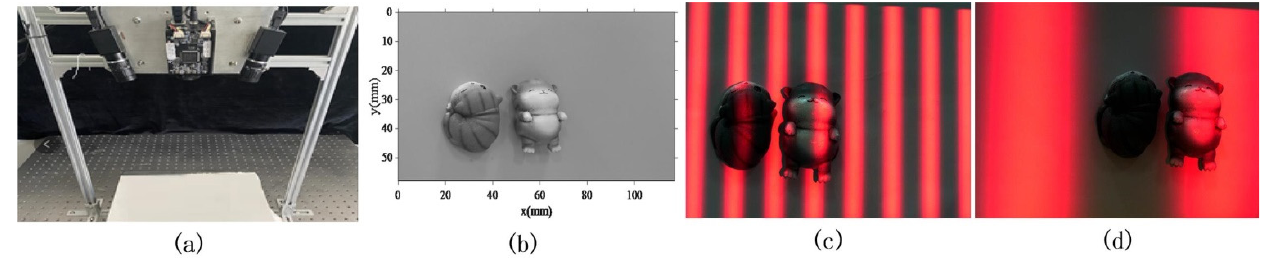
Figure 1. The isolated objects and fringe pattern. ( a ) The structure of the reconstruction system; ( b ) the image of the isolated objects; ( c ) the fringe pattern of high frequency; ( d ) the fringe pattern of low frequency.